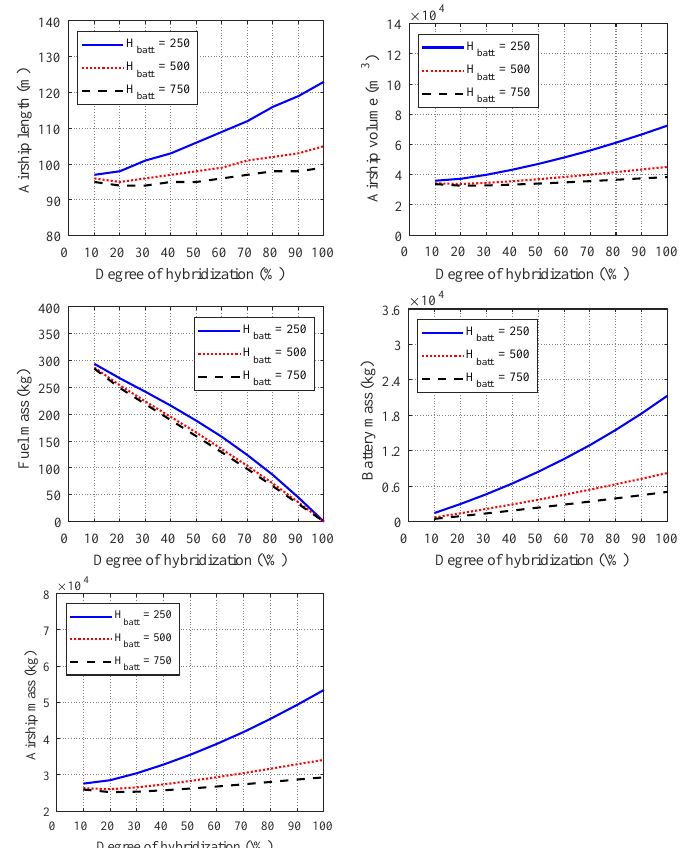
Figure 13. Optimal output as a function of hybridization